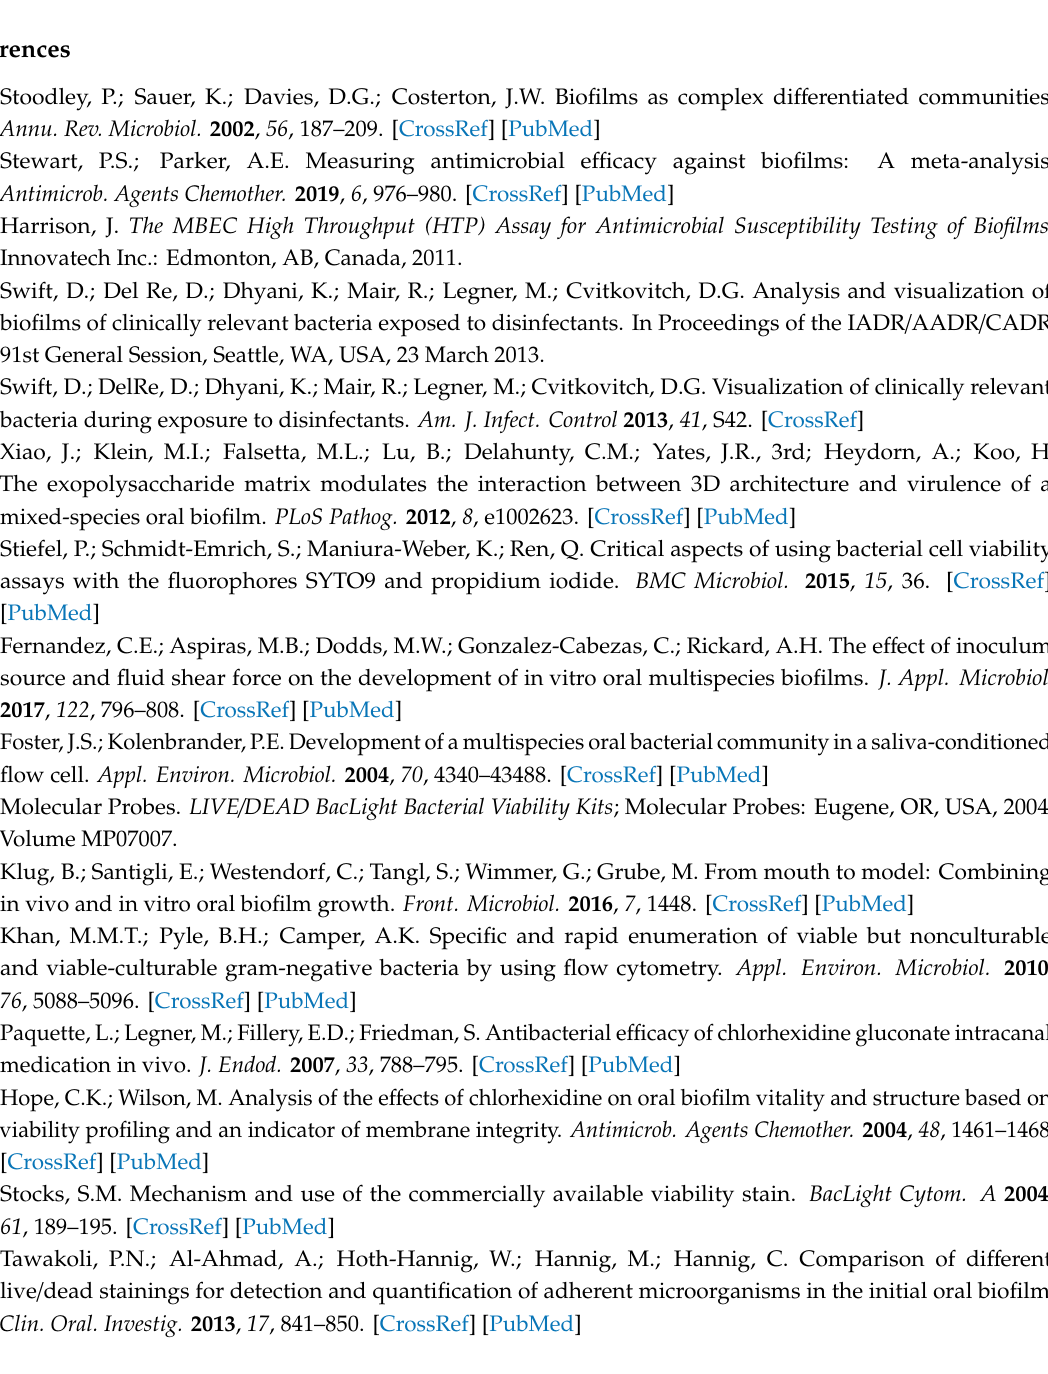
Figure S1: The Ibidi flow cell (Slide VI 0.4 Ibi Treat; Ibidi, USA) mounted firmly in the microscope stage insert (Universal Insert 160x110 mm, Applied Scientific Instruments,